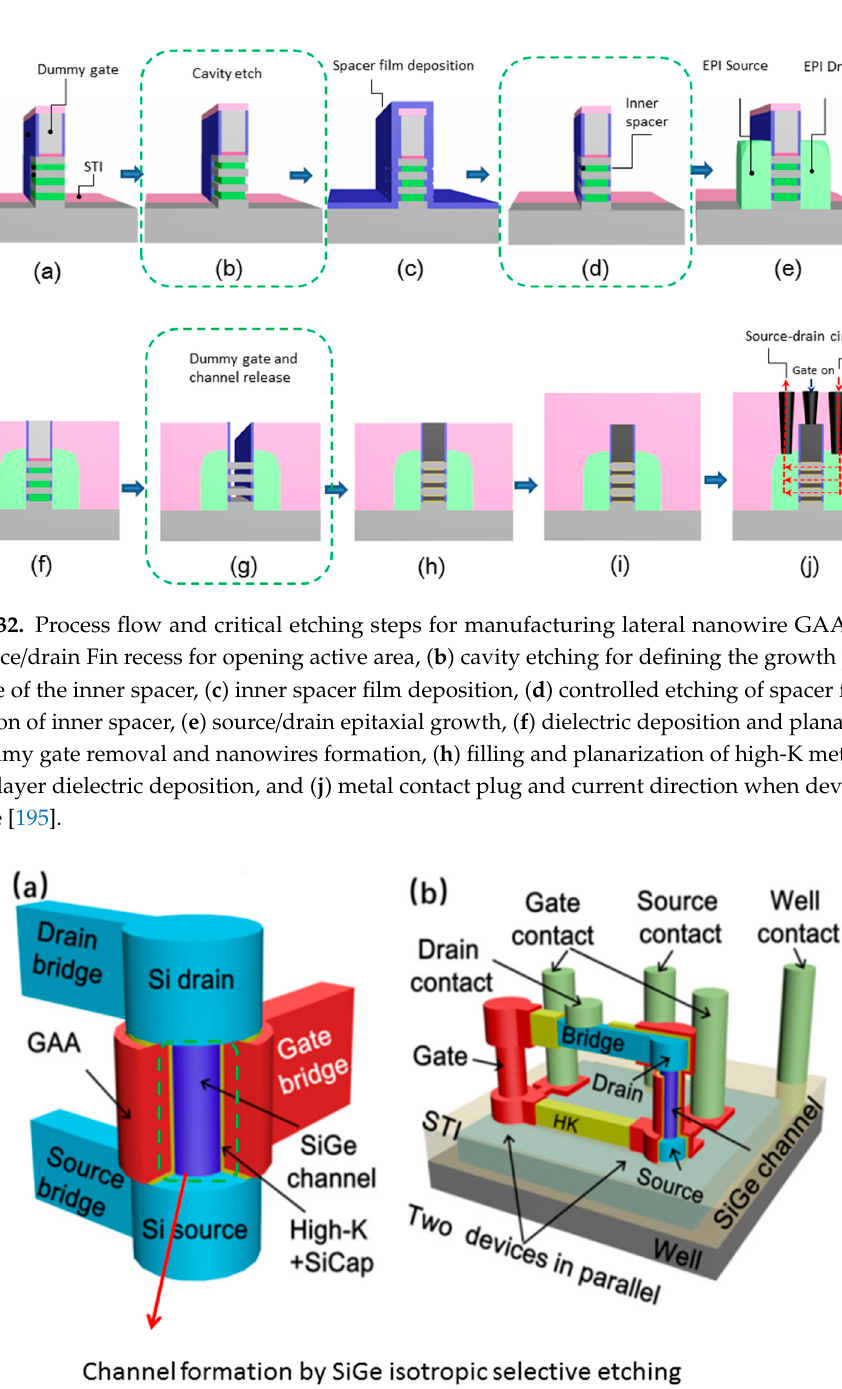
Figure 33. Schematic of vertical nanowire GAA transistor: ( a ) Structural design for a single device, and ( b ) test structure with two devices connected in parallel via a local interconnect bridge [46].